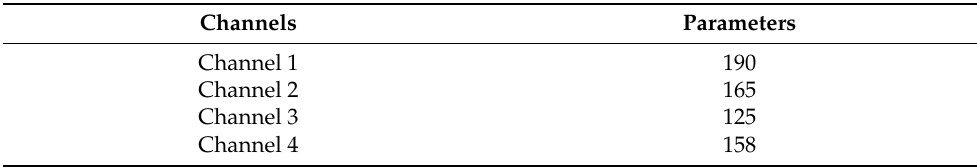
Figure 16. Multi- channel. Table 14 is the result of conventional multi-channel throughput. Table 14 is the result of conventional multi-channel throughput. Table 14. Throughput parameters multi Table 14. Throughput parameters multi channel.